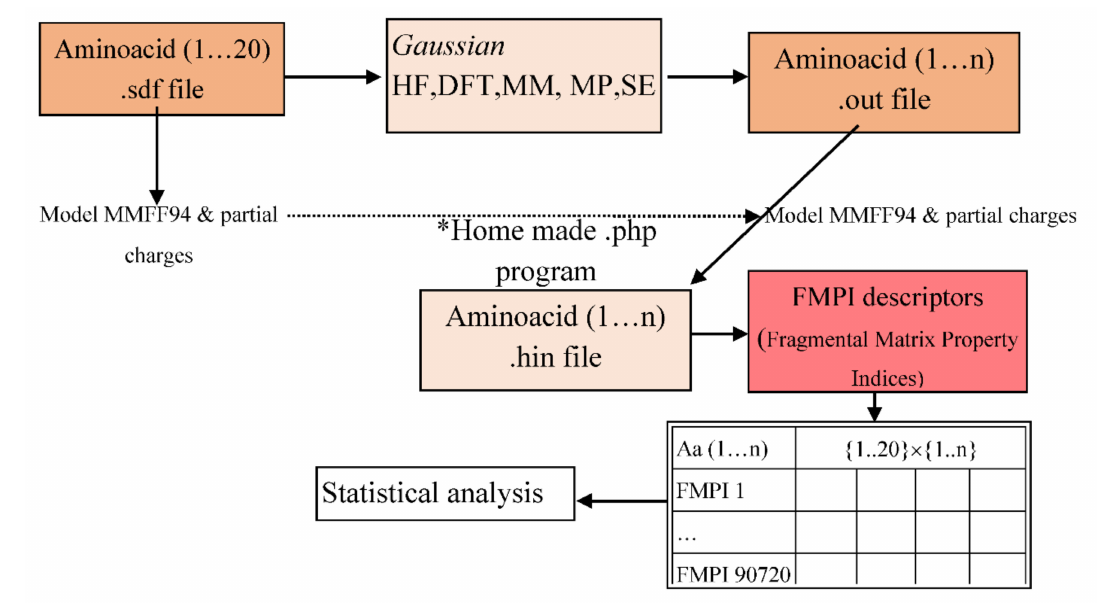
Figure 1. The working